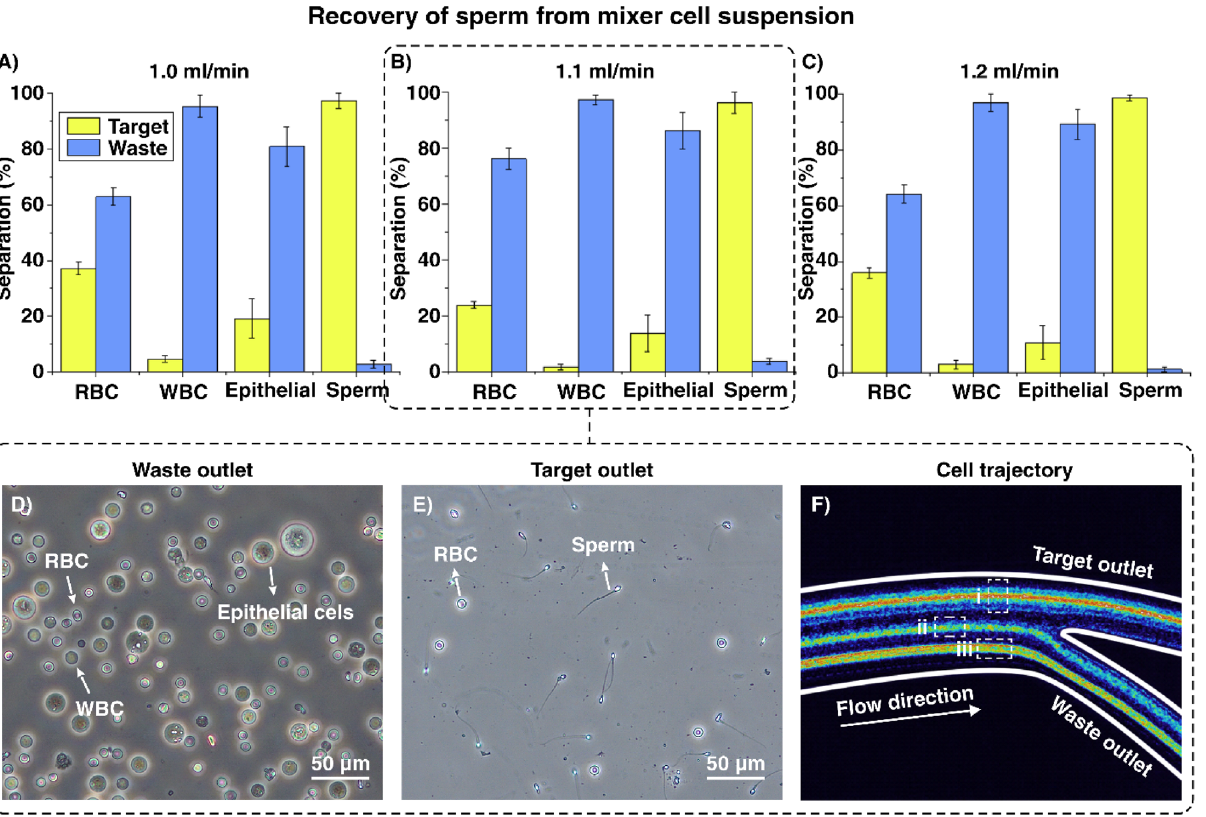
Figure 3. Separation efficiency of cells per outlet at the flow rate of ( A ) 1 mL/min, ( B ) 1.1 mL/min, and ( C ) 1.2 mL/min where N = 10 for peach panel and separation efficiency is presented as the average percentage efficiency ± standard deviation. ( D , E ) Side-by-side example brightfield images of collected waste and target fractions collected from microfluidic sorting at 1.1 mL/min respectively. ( F ) Stacked distribution of cell focusing bands at 1.1 mL/min where (i) depicts the combined focusing of sperm cells and RBCs through the target outlet, (ii) depicts the presence of WBCs moving towards the waste outlet, and (iii) depicts a more concentrated band of RBCs exiting through the waste